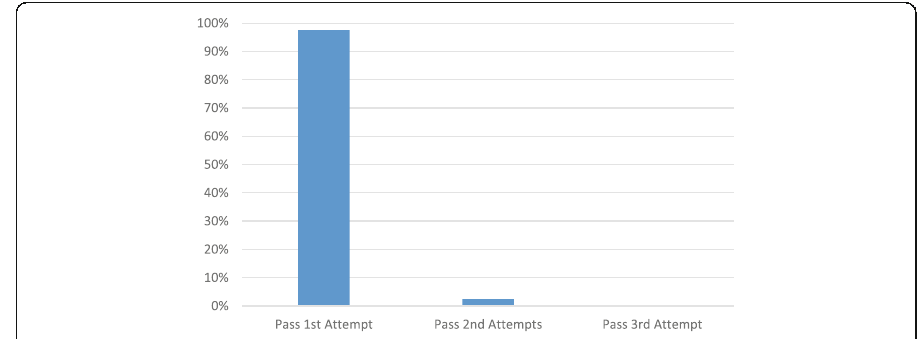
Fig. 12 Percentage of the number of attempts by trainees to pass their courses over one